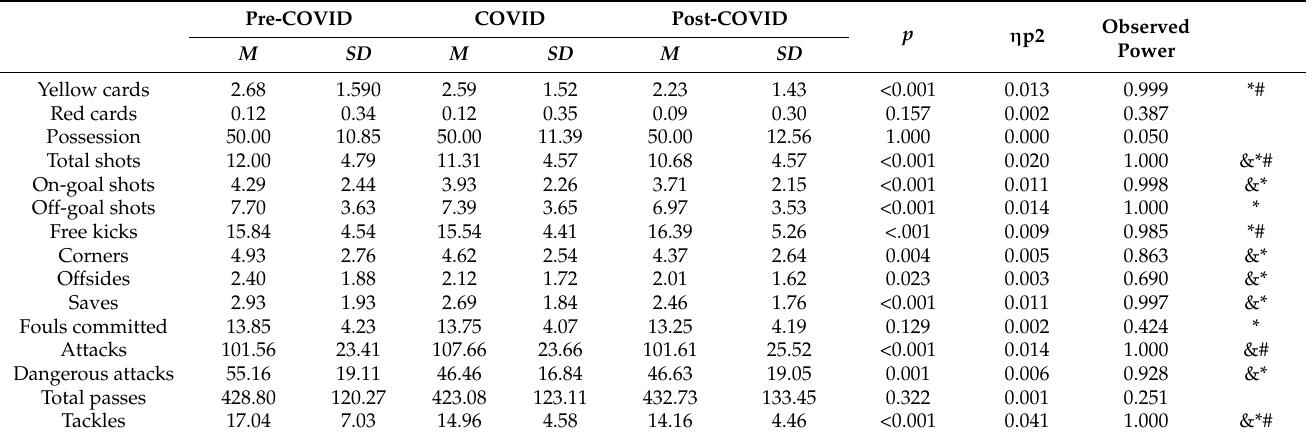
Table 2. Descriptive and inferential results of the influence of COVID on performance indicators.